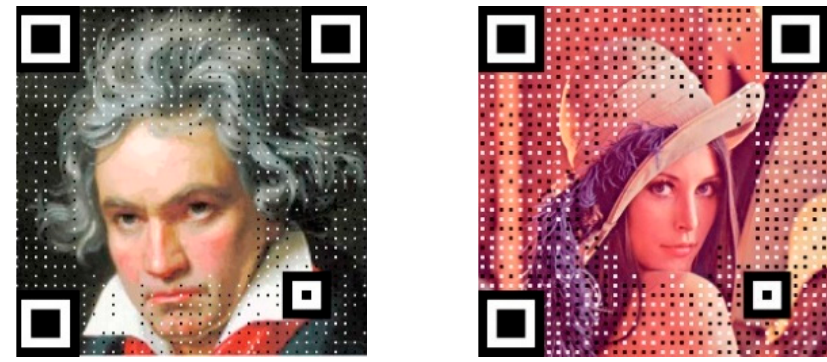
Figure 3. Sample QR Codes generated from [30].